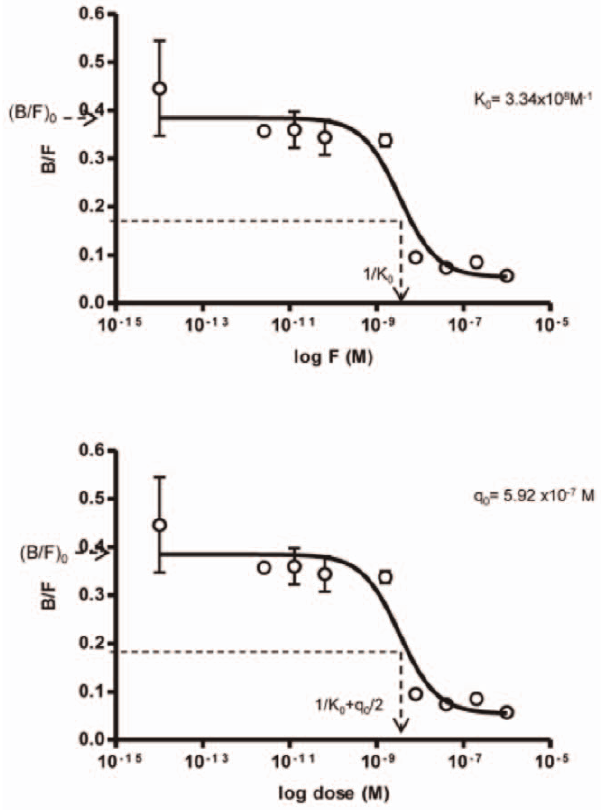
Figure 1. Dose-response curves obtained by using rabbit anti- human-PI serum and standard PI in a fluid phase displacement experiment incubated until reaching equilibrium. The parameter 1/K 0 was calculated by interpolation at (B/F) 0 /2 in the upper graphic [B/ F=f(log F)]. In the lower graphic representing B/F=f(log dose) the (B/ F) 0 /2 intercepts the abscisa axis at 1/K 0 + q 0 /2 [21].